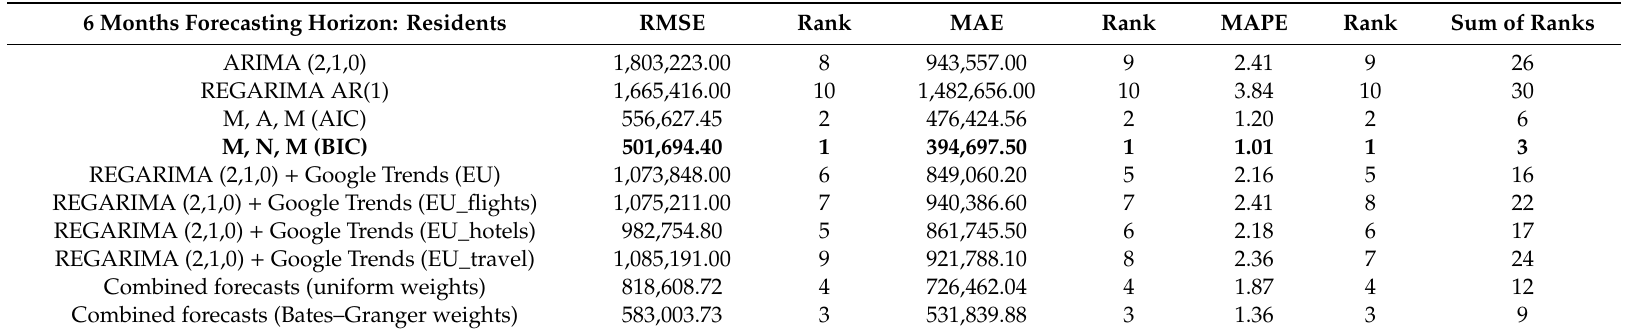
Table A4. Forecasting accuracy (December 2017): arrivals, residents, six months ahead. Source: European Commission (2017) and own calculations. Boldface indicates the single forecasting model(s) / forecast combination technique(s) characterized by the lowest sum of ranks. 6 Months Forecasting Horizon: